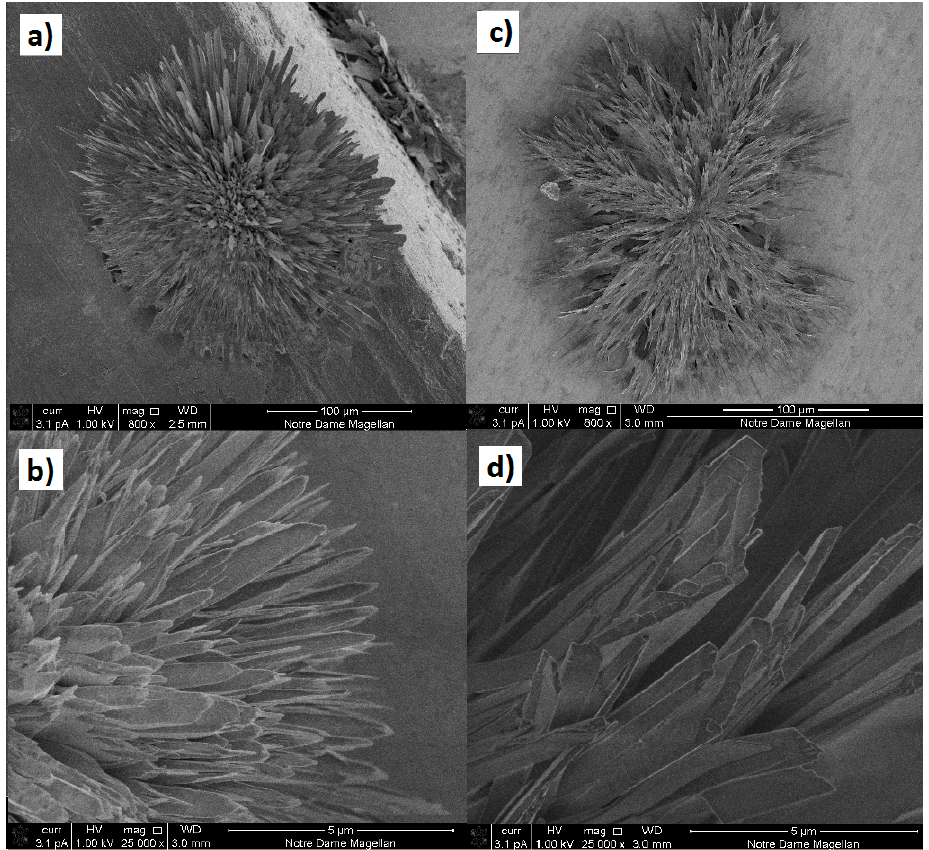
Figure 2. SEM images of Q crystals grown from saturated solutions of Q in methanol ( a , b ) and in acetone ( c , d ).